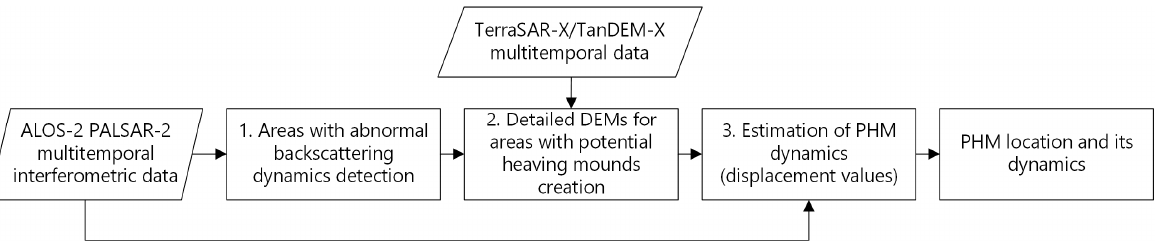
Figure 2. Flowchart of the proposed methodology for detection and study of PHM.